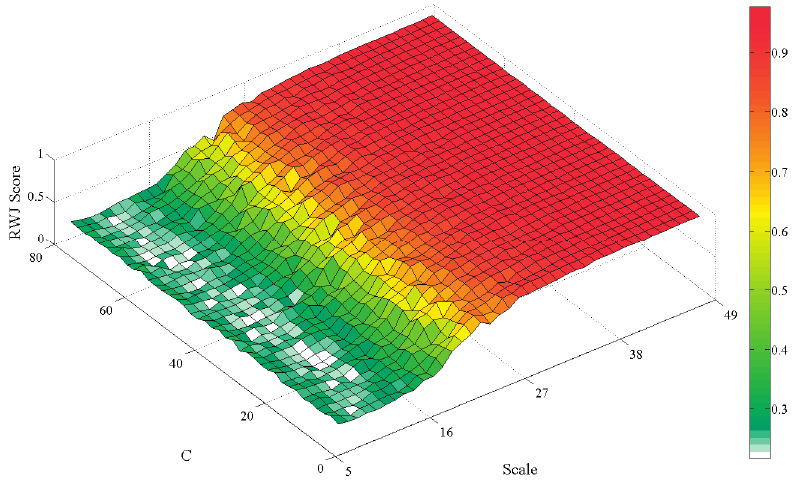
Figure 18. Search landscape slice with the Scale and two-class SVM C parameter of the Hybrid:CP method variant.